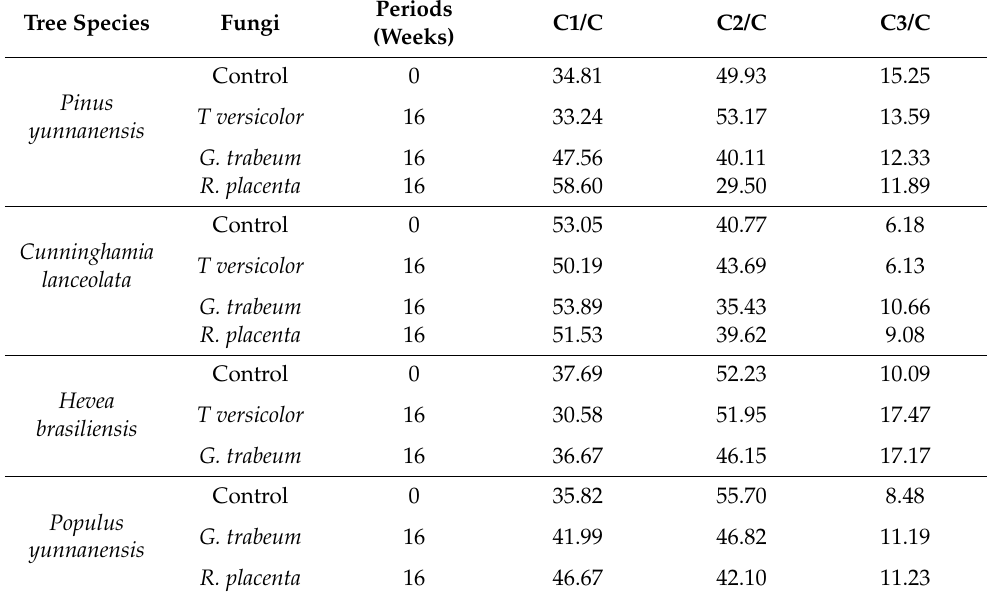
Table 4. C (1s) Division peak percentage contents of wood surface after